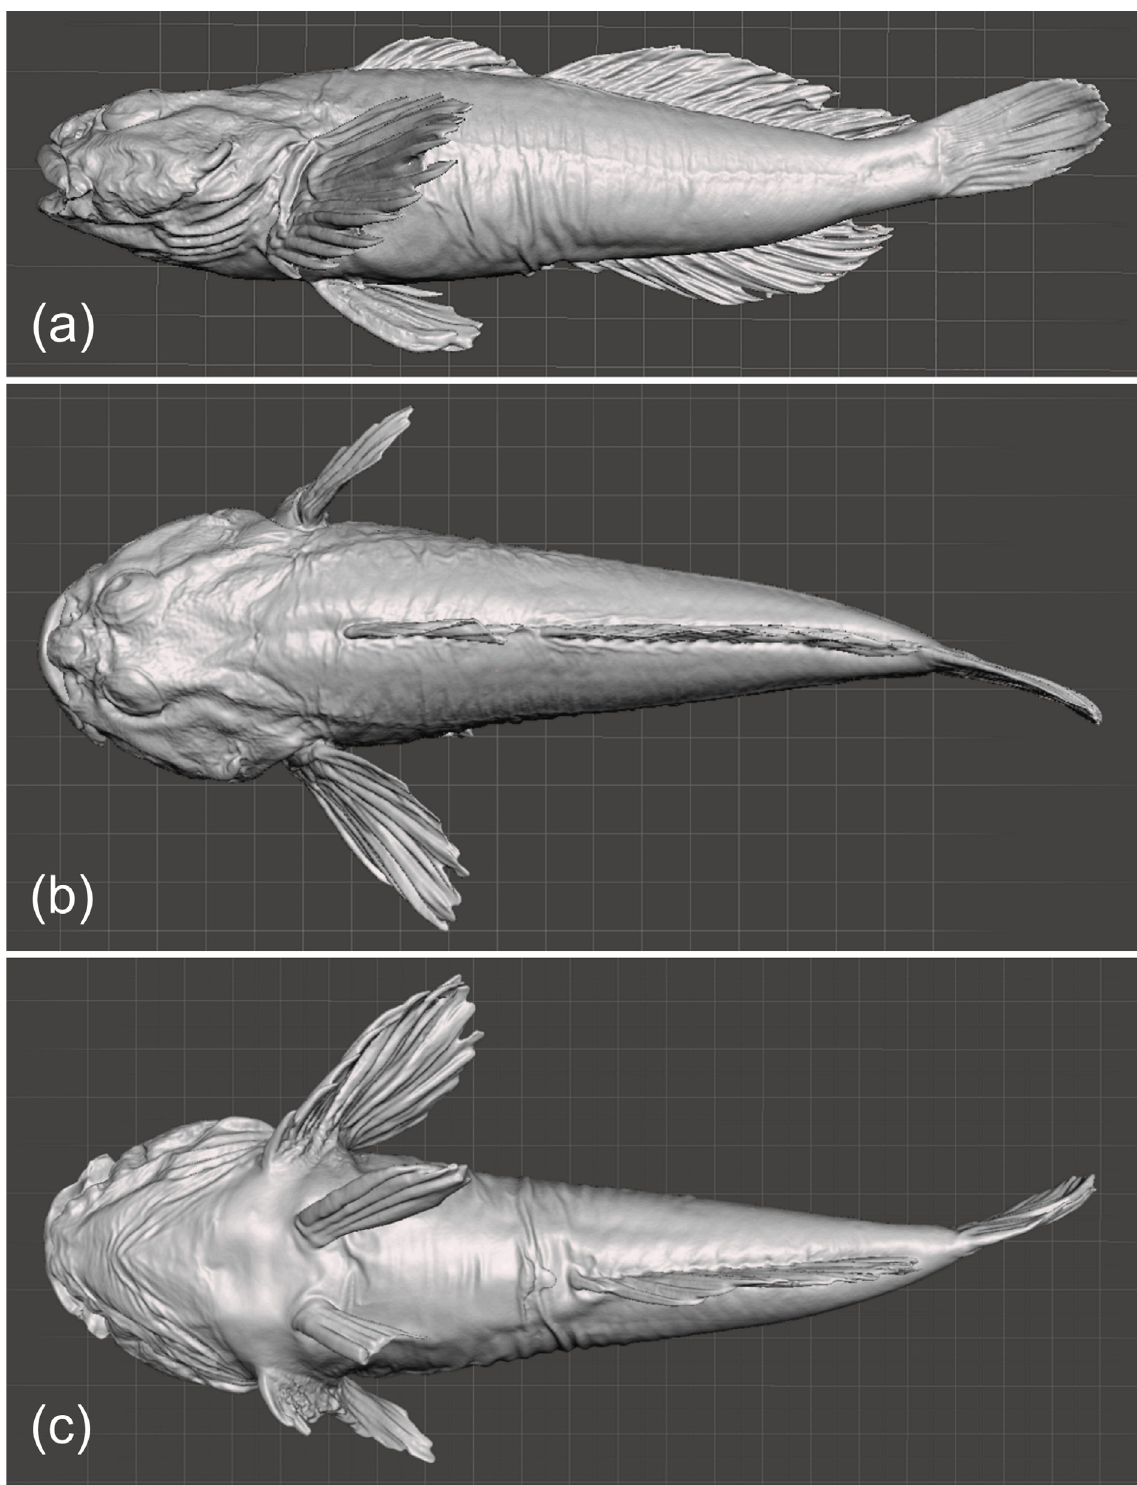
Fig. 2 . Cottus cyclophthalmus sp. nov., holotype, ♂ (ZIN 56687), SL 83.3 mm, TL 99.0 mm, Krasnaya River, near Tokarevka village, 54º24'59.4" N 22º23'50.4" E. 3D scan images. a . Lateral view. b . Dorsal view. c . Ventral